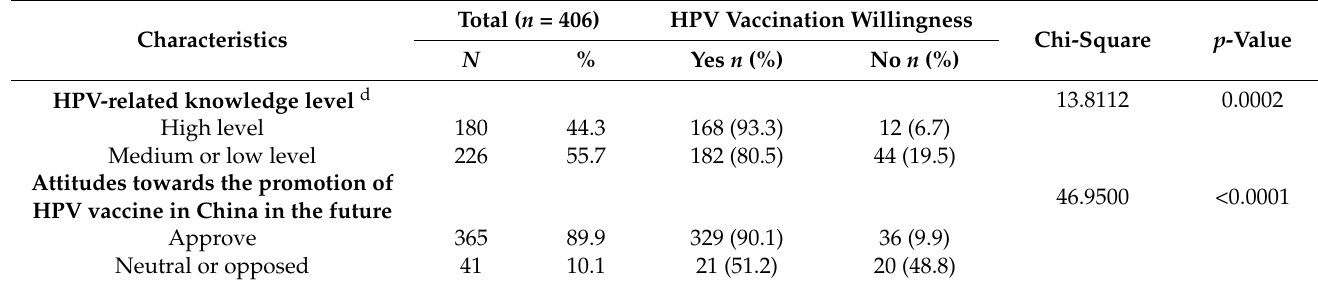
Table 5. Relationship between HPV-related knowledge, promotion attitude, and HPV vaccination